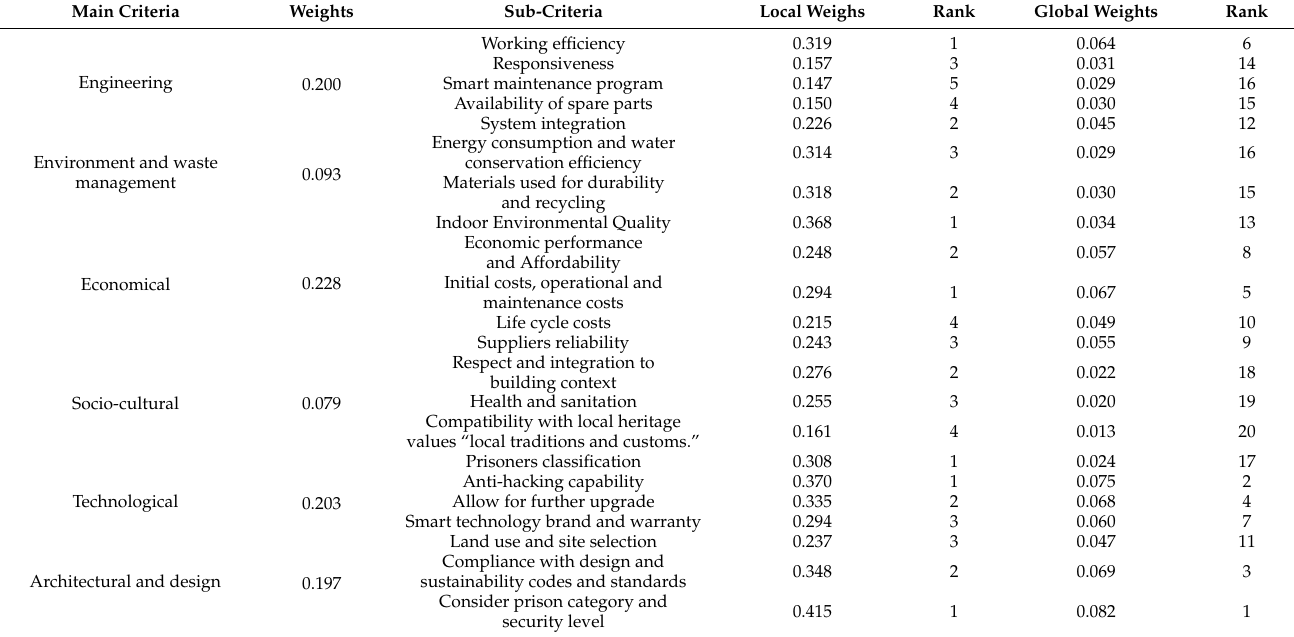
Table 2. Weights of main criteria and sub-criteria.